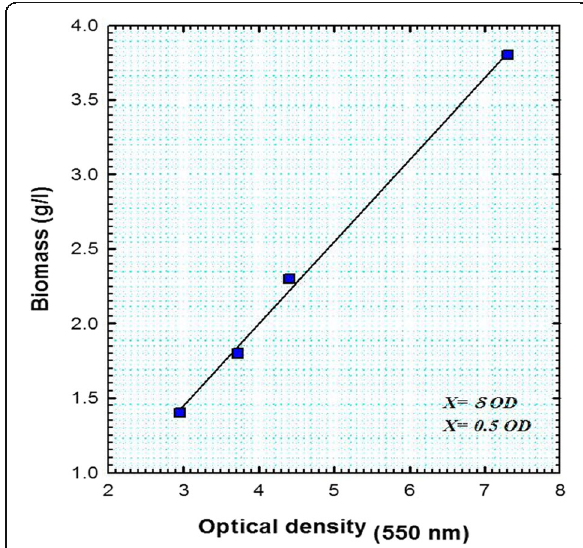
Fig. 10 The correlation between optical density (OD 550nm ) and biomass (g/l) in the exponential growth phase of batch fermentation no. 2 of Bacillus subtilis isolate B10